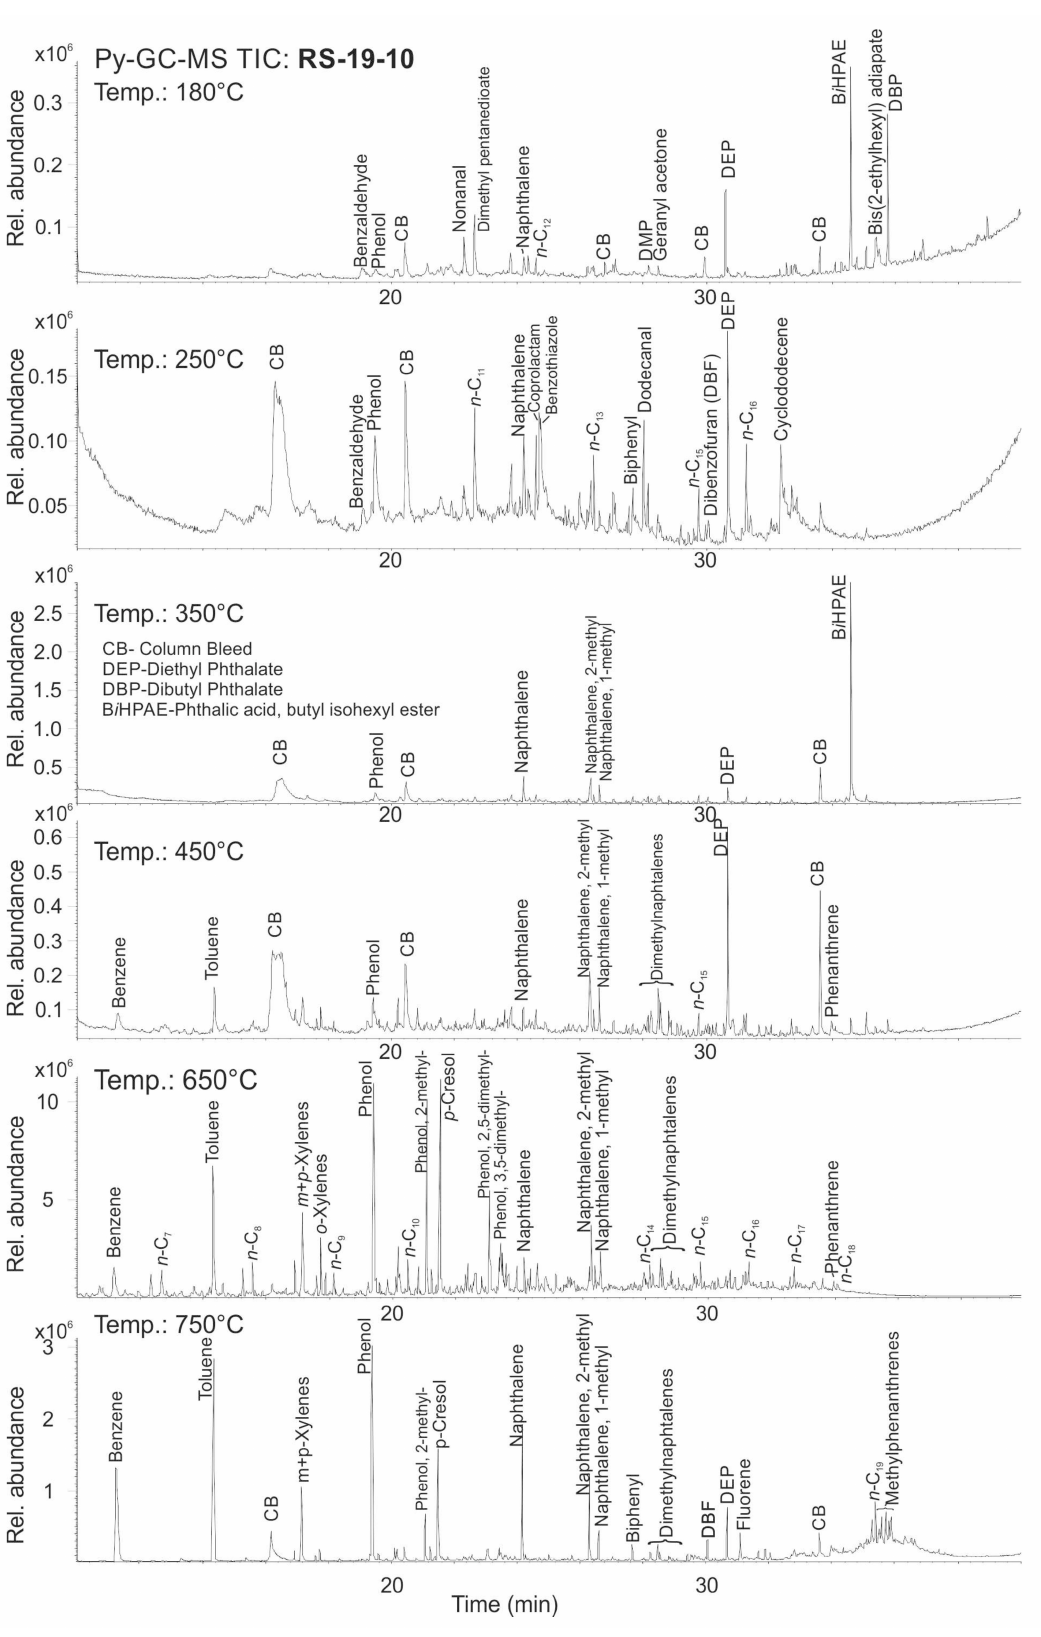
Figure 4. The total ion chromatograms (TIC) of pyrolysates of the RS-19-10 sample.Rel., relative; Temp.,